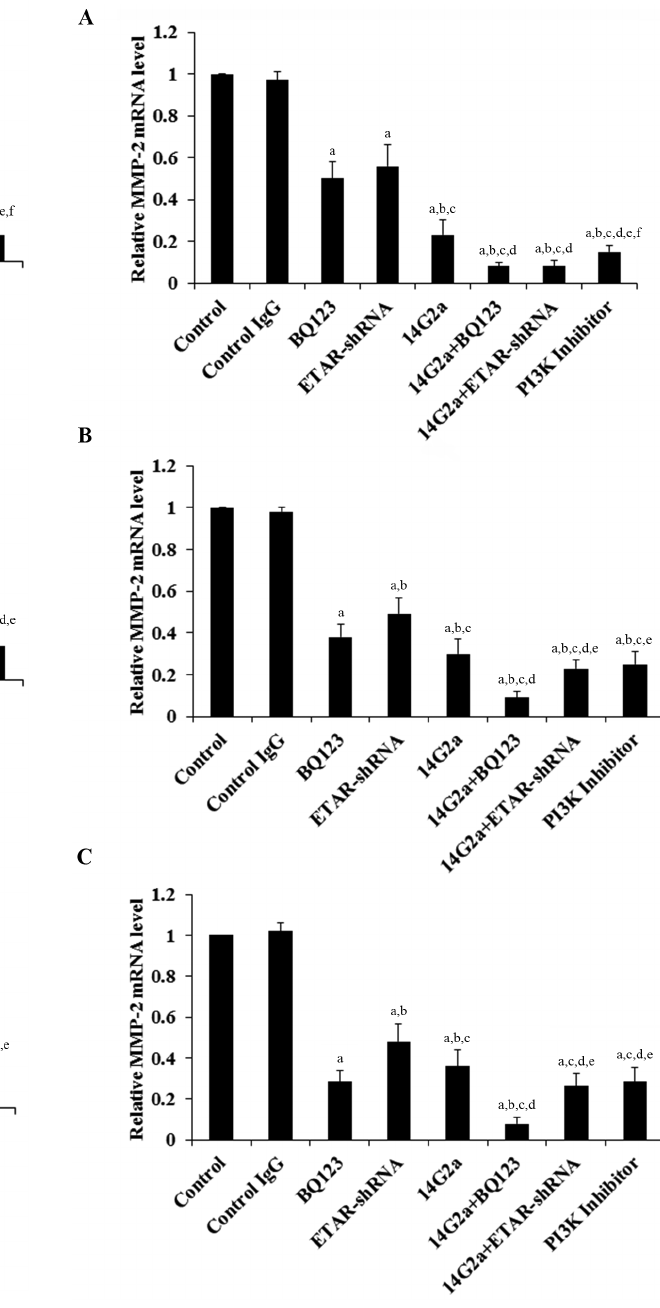
Figure 2. Effects of anti-ganglioside GD2 14G2a monoclonal antibody (mAb) alone or in combination with ET A receptor (ETAR) antagonist on osteosarcoma (OS) cell invasiveness. In vitro cell invasion assays were performed with a Fluorimetric Cell Invasion Assay kit (Chemicon; Millipore) in Saos-2 ( A ), MG-63 ( B ) and SJSA-1 ( C ) OS cells treated with control IgG (PK136 mAb, 50 m g/mL), 14G2a mAb (50 m g/mL), selective ETAR antagonist BQ123 (5 m M), and 14G2a (50 m g/mL) + BQ123 (5 m M) for 48 hours. Cells with knockdown of ETAR (ETAR-shRNA) with or without 14G2a mAb treatment were also tested. Cells treated with selective phosphatidylinositide 3-kinase (PI3K) inhibitor BKM120 (50 m M) was used as a positive control. Cell invasion was determined by fluorescence and shown as fold changes to that of the untreated control cells (designated as 1). Each experiment was repeated for three times in duplicates. Data values were expressed as Mean + SD. a p , 0.05 vs. control or control IgG; b p , 0.05 vs. BQ123; c p , 0.05 vs. ETAR-shRNA; d p , 0.05 vs. 14G2a; e p , 0.05 vs. 14G2a + BQ123; f p , 0.05 vs. 14G2a + ETAR-shRNA. doi:10.1371/journal.pone.0093576.g002 PLOS ONE |